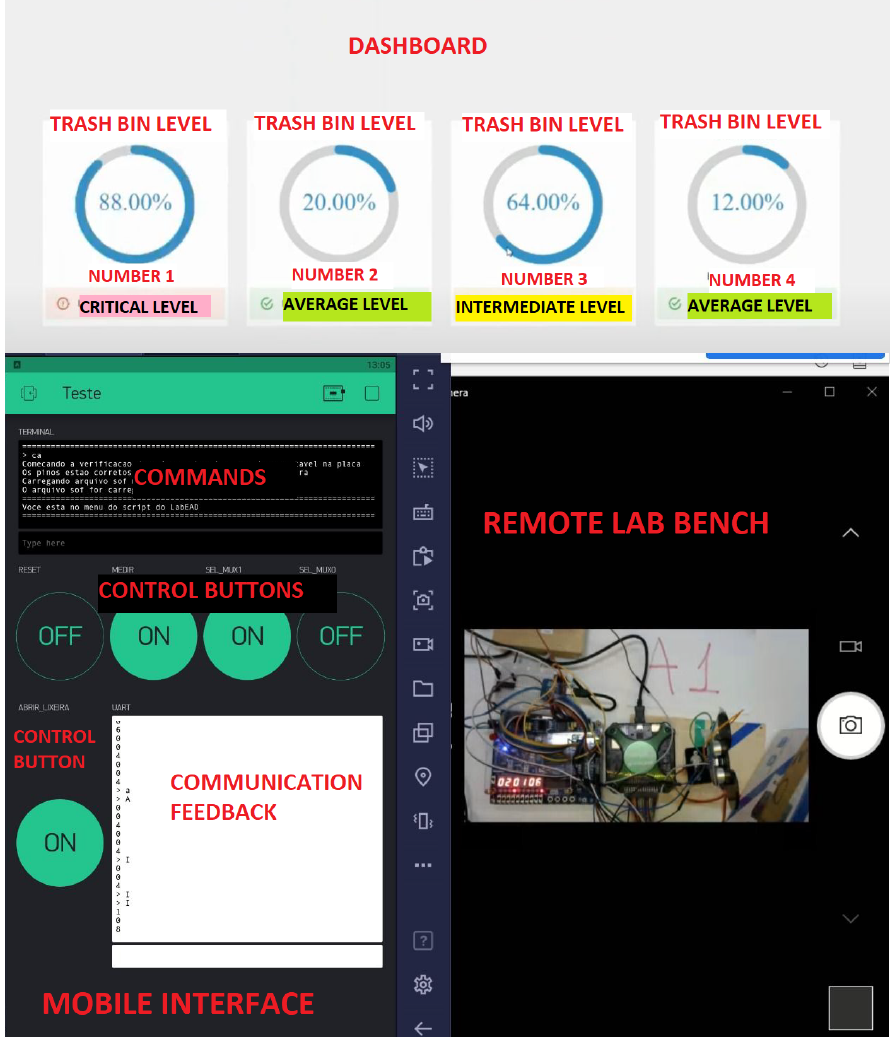
Figure 5. Smart Trash Bin